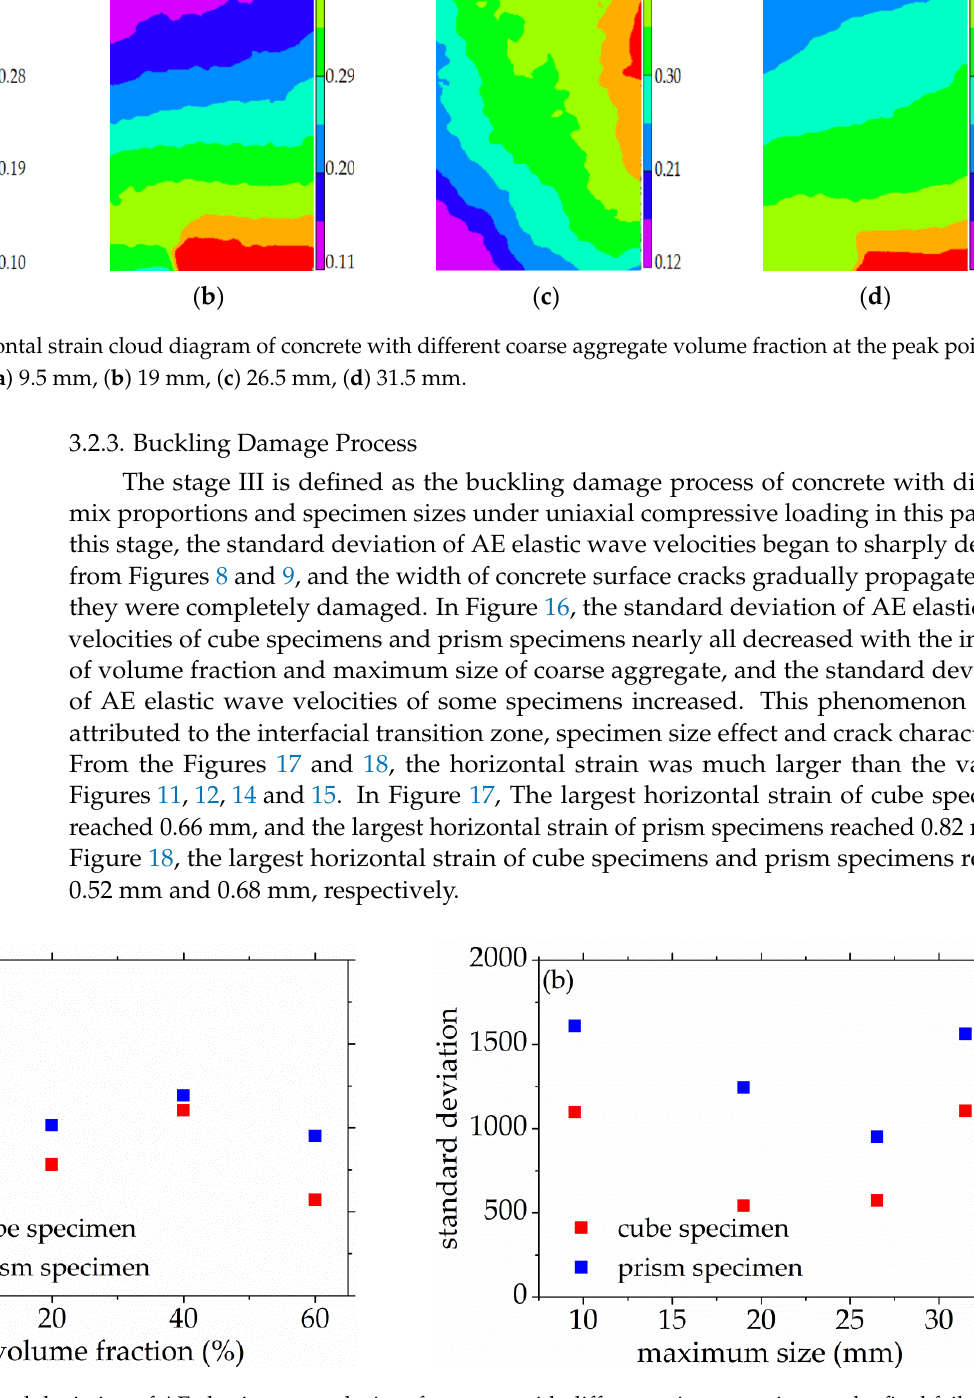
Figure 16. The standard deviation of AE elastic wave velocity of concrete with different mix proportions at the final failure state, ( a ) volume fraction, ( b ) maximum size.